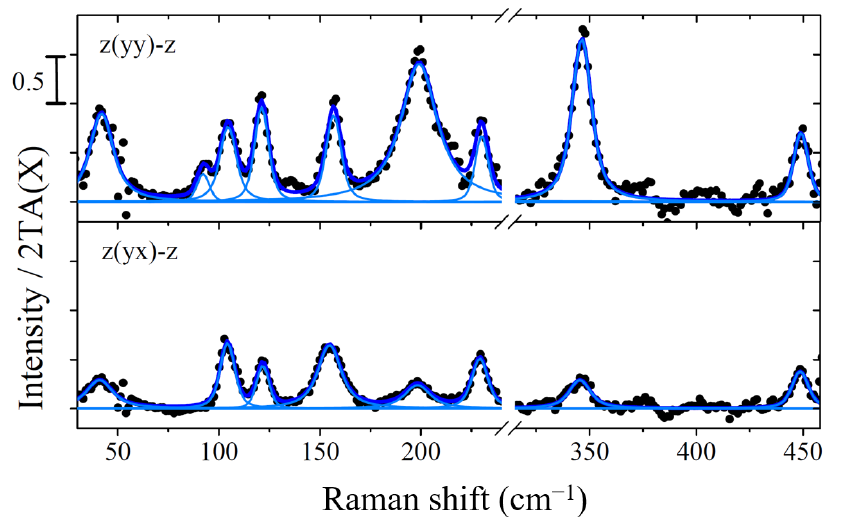
Figure 2. Surface Raman spectra of the terbium silicide layer grown on 4 ◦ -offcut Si(111) substrate for parallel z(yy)-z and crossed z(yx)-z polarization configurations. The spectra are fitted with Voigt profiles with a fixed Gauss width equal to the spectral resolution of 3.5cm − 1